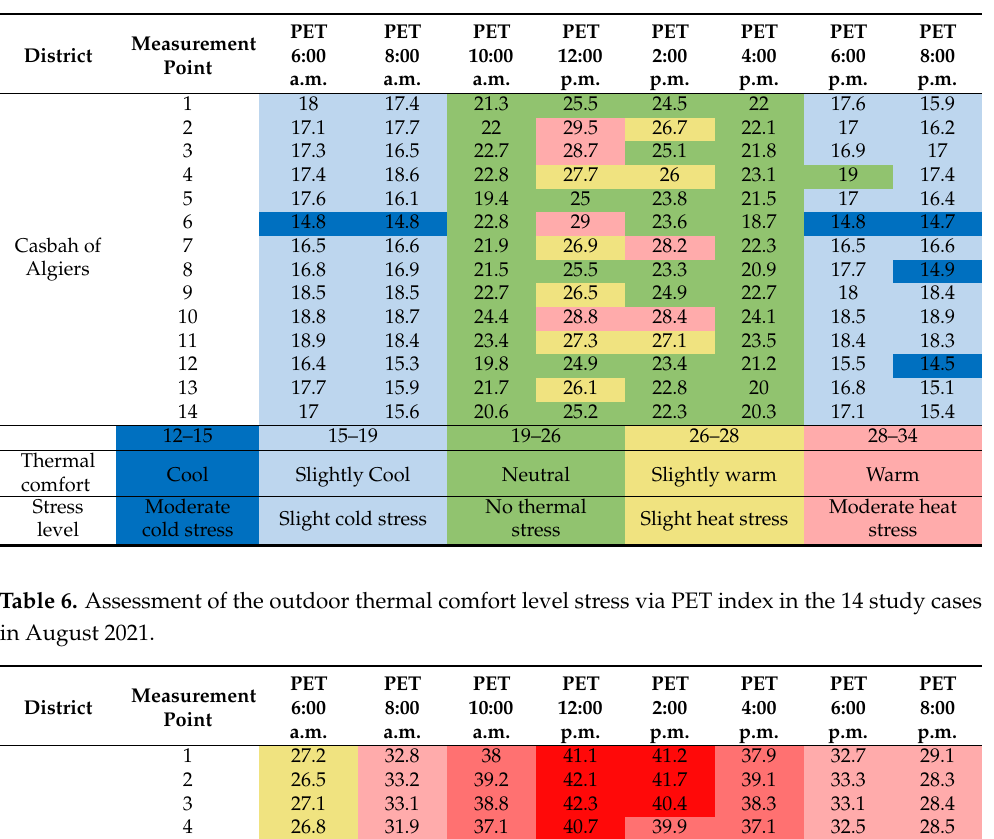
Table 5. Assessment of the outdoor thermal comfort level stress via PET index in the 14 study cases in January 2021.